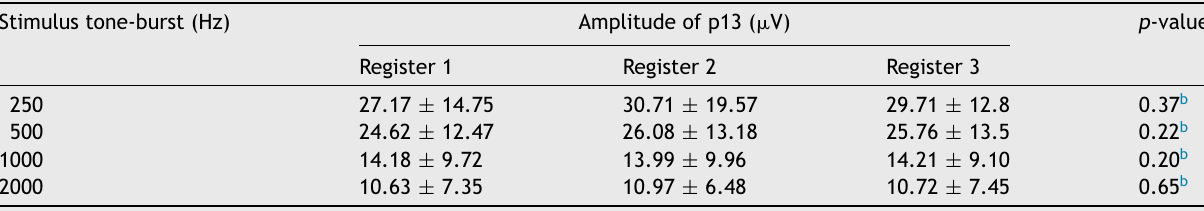
(cid:2) V, microvolts; Hz, Hertz. a Data expressed as mean ± standard deviation. b Analysis of variance